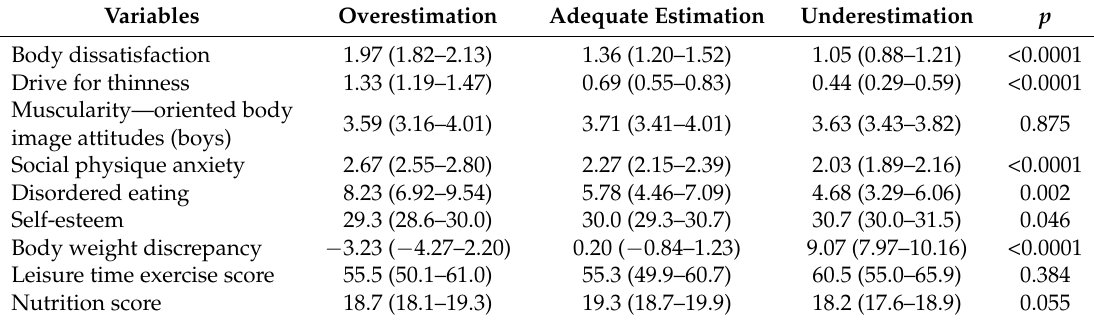
Table 5. Comparison of body image concerns and exercise between body weight discrepancy groups (m, 95% CI) 1 , ( n =